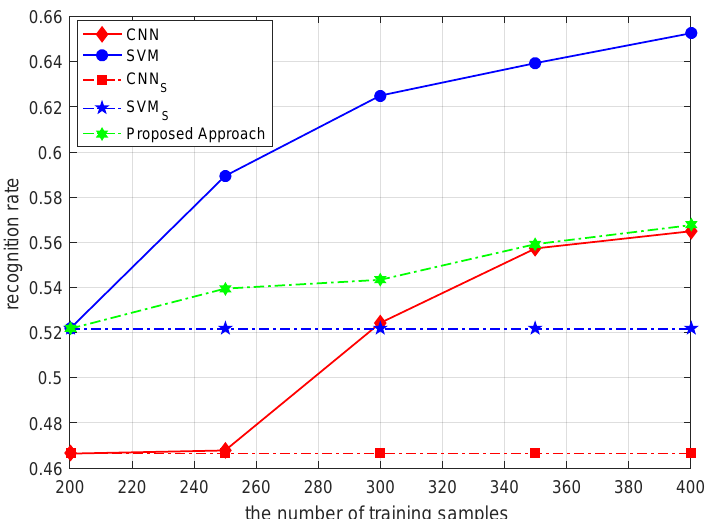
Figure 12. The comparing results of ship recognition performance between different recognition models. The solid line indicates the recognition rate of different recognition models when the amount of SAR target samples is sufficient. The dotted line indicates the recognition rate of different recognition models when the ATR model solves the dilemma of a small sample